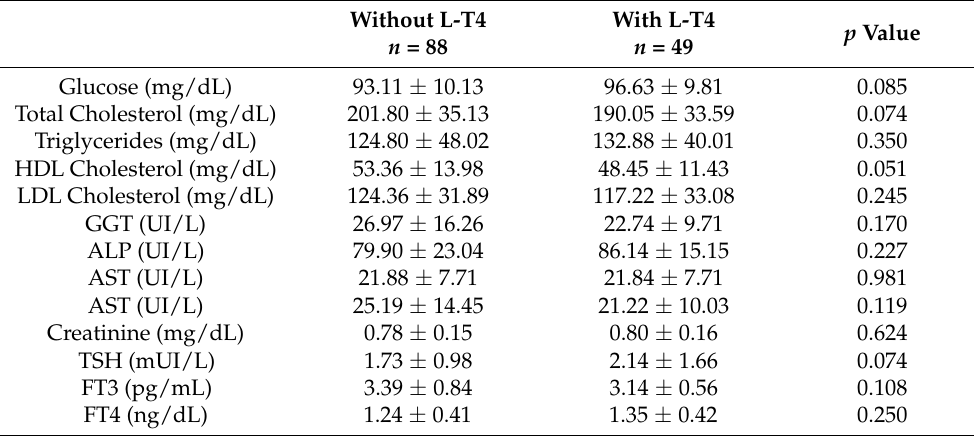
Table 2. Mean +/ − SD Participants’ laboratory characteristics according to L-T4 use.